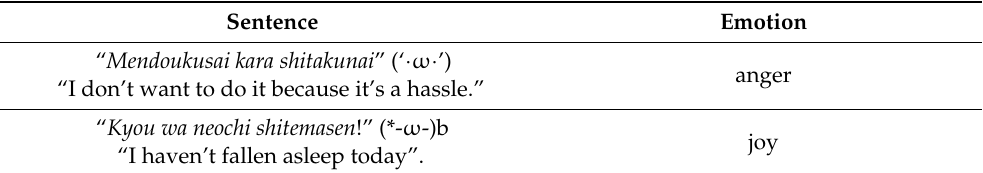
Table 7. Example of sentence classified correctly using only the proposed